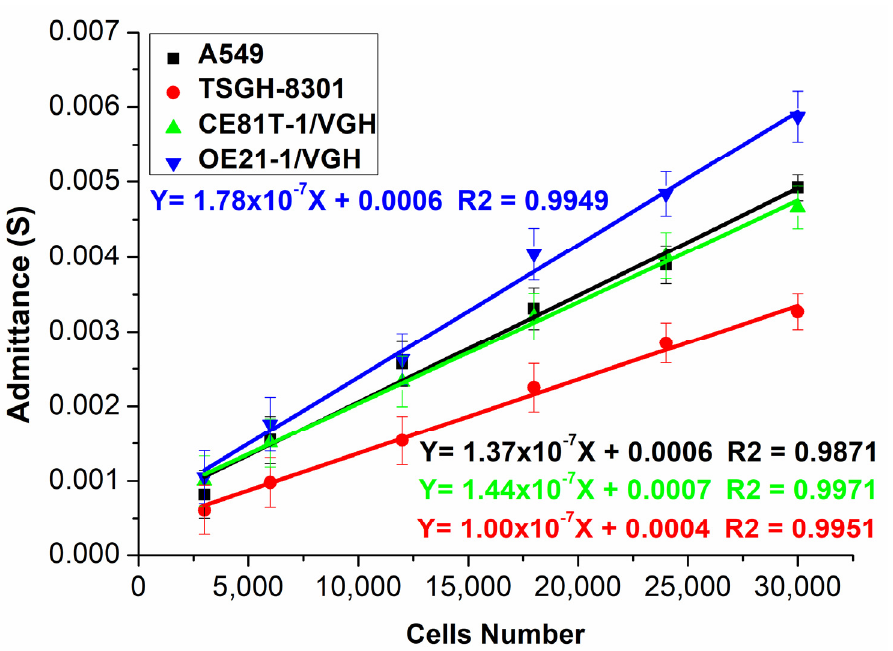
Figure 3. Admittance values vs. number of cells in four cancer cells. Error bars represent the standard deviation of the measurement ( n = 5).